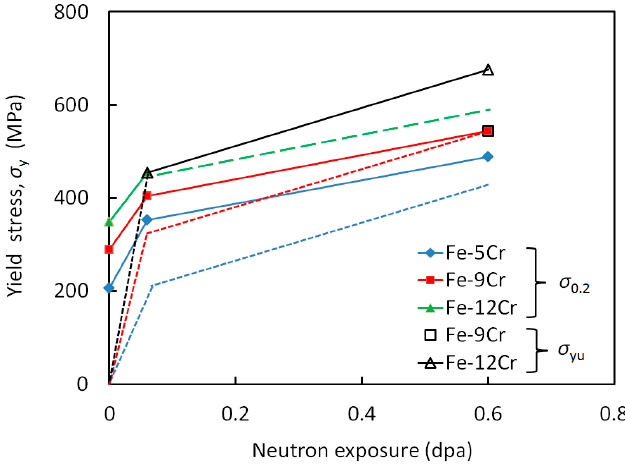
Figure 2. Yield stress versus neutron exposure for the Fe-Cr alloys. The meaning of the types of lines is explained in the main text. Errors of the yield stress were within 10%.